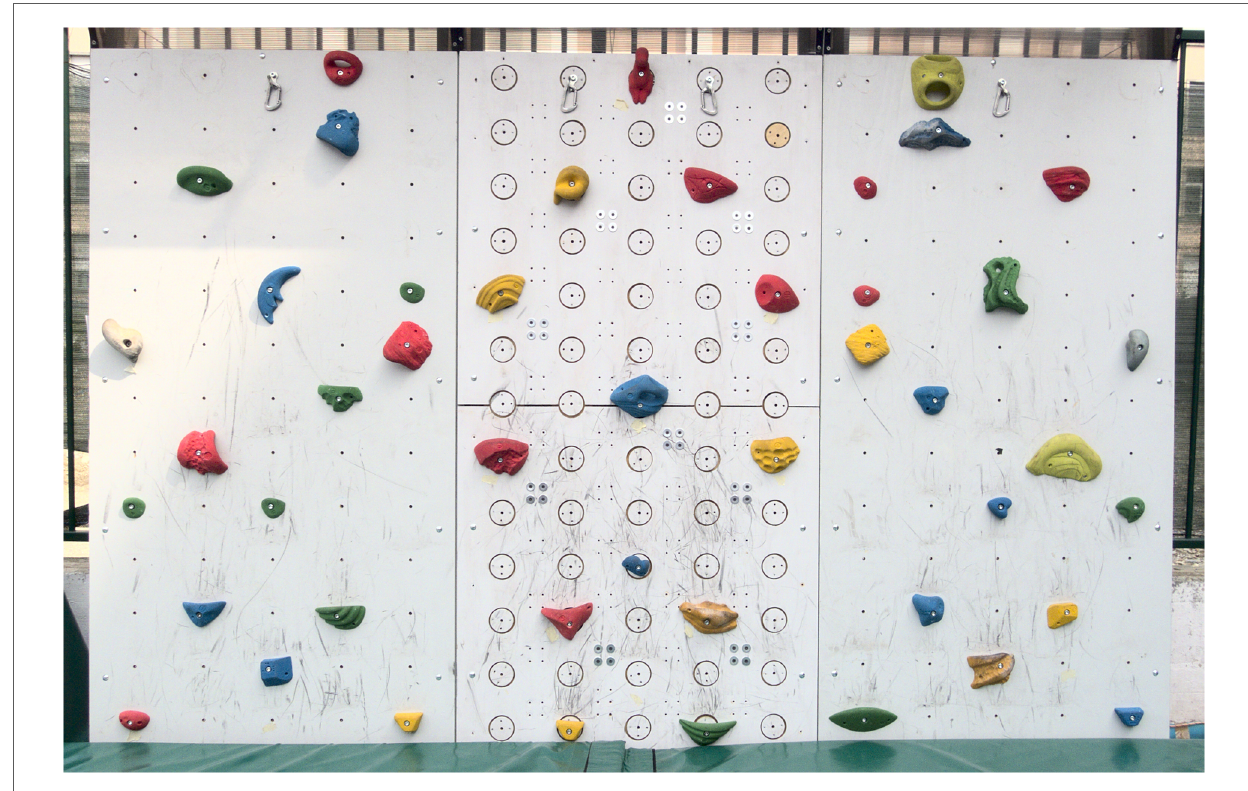
FIGURE 1 Prototype of the sensorized wall. The wall is composed of three modules side by side; in this case, only the central module is equipped with